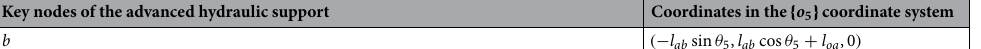
Table 12. Coordinates of node b in the { o 5 } coordinate system.